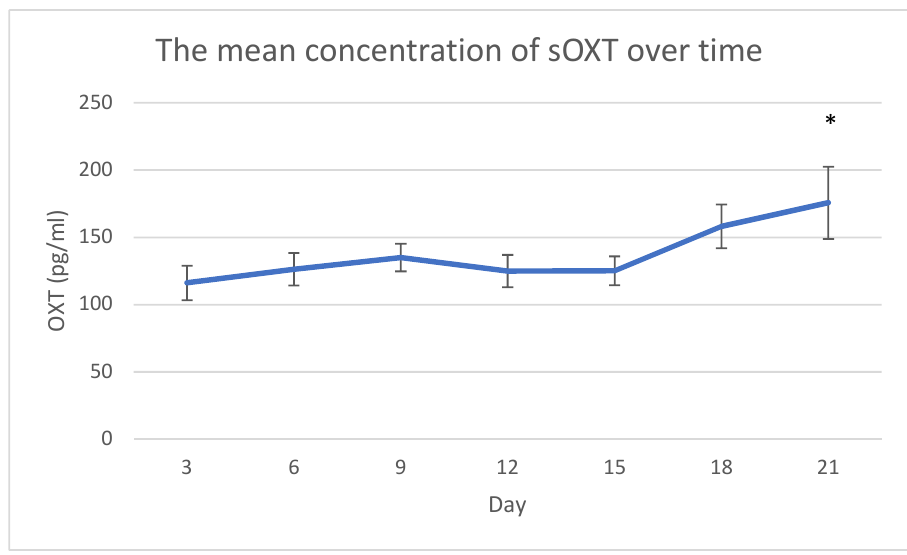
Figure 1. The mean concentration of salivary oxytocin (sOXT) across observations. Error bars indicate standard error of the mean. * p < 0.05 versus day 3, 6, 12 and 15.